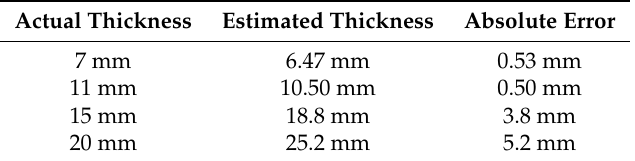
Table 5. GP model accuracy on testing data, i.e., grey cast iron calibration blocks (with 2 mm lift-off).